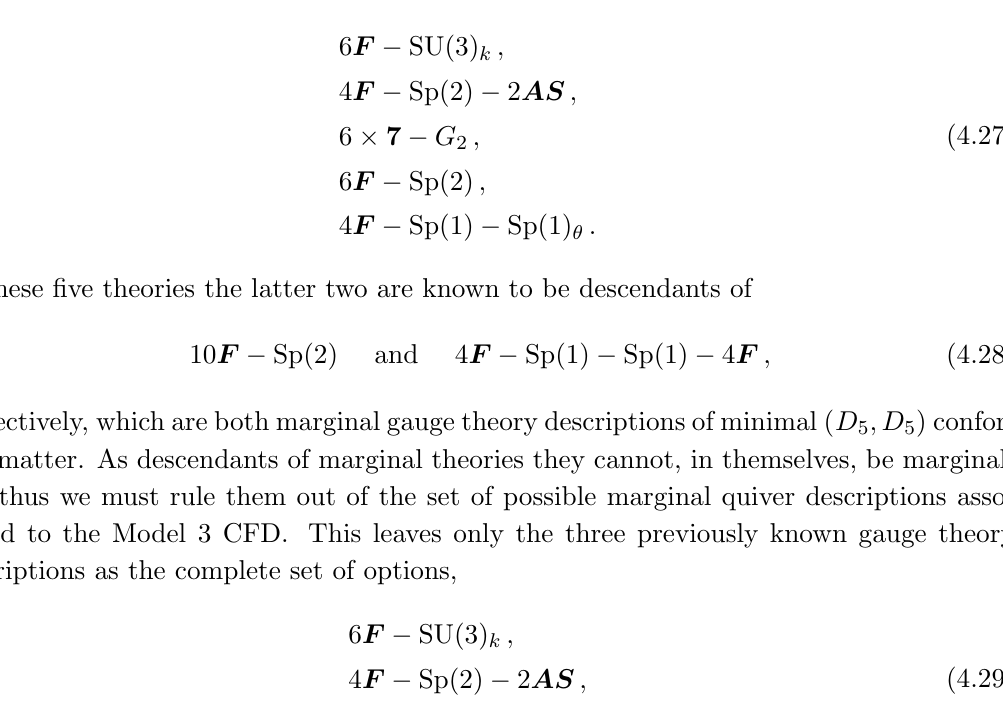
Figure 14. Embedding of BG-CFDs into the marginal CFDs of Model 3 of the rank 2 classi(cid:12)cation. From the embedding the classical (cid:13)avor symmetry, and thereby G BG can be read o(cid:11). Compatibility with the (cid:12)xed (cid:13)avor rank, r = 7, leaves only (cid:12)ve possible F